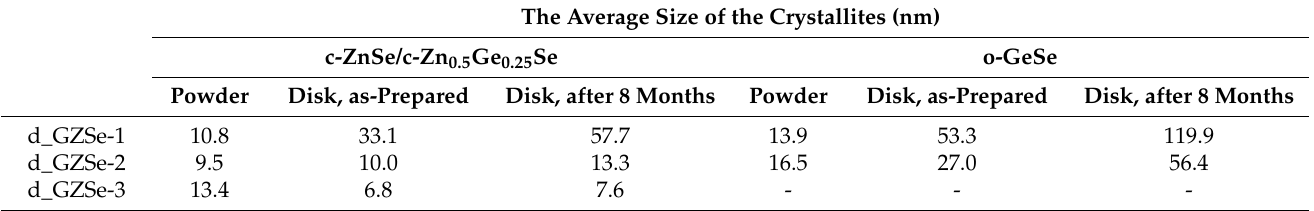
Table 3. The average size of the crystallites for the phases formed in the powders and in the sintered glass-ceramics, as-prepared and after 8 months of Ambiental storage (aging). The Average Size of the Crystallites